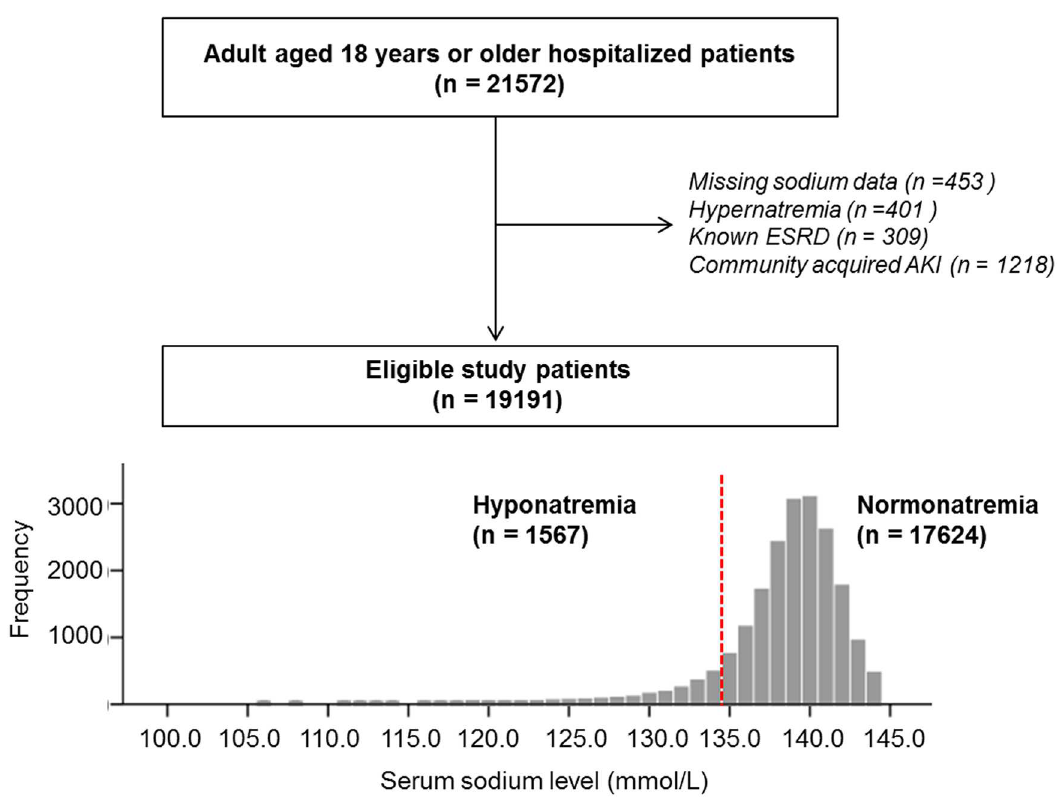
Fig 1. Algorithmfor eligible patientselection. Hypernatremiais definedas sodium145 mmol/Lor higher. ESRD, end stage renaldisease; AKI, acute kidney injury.